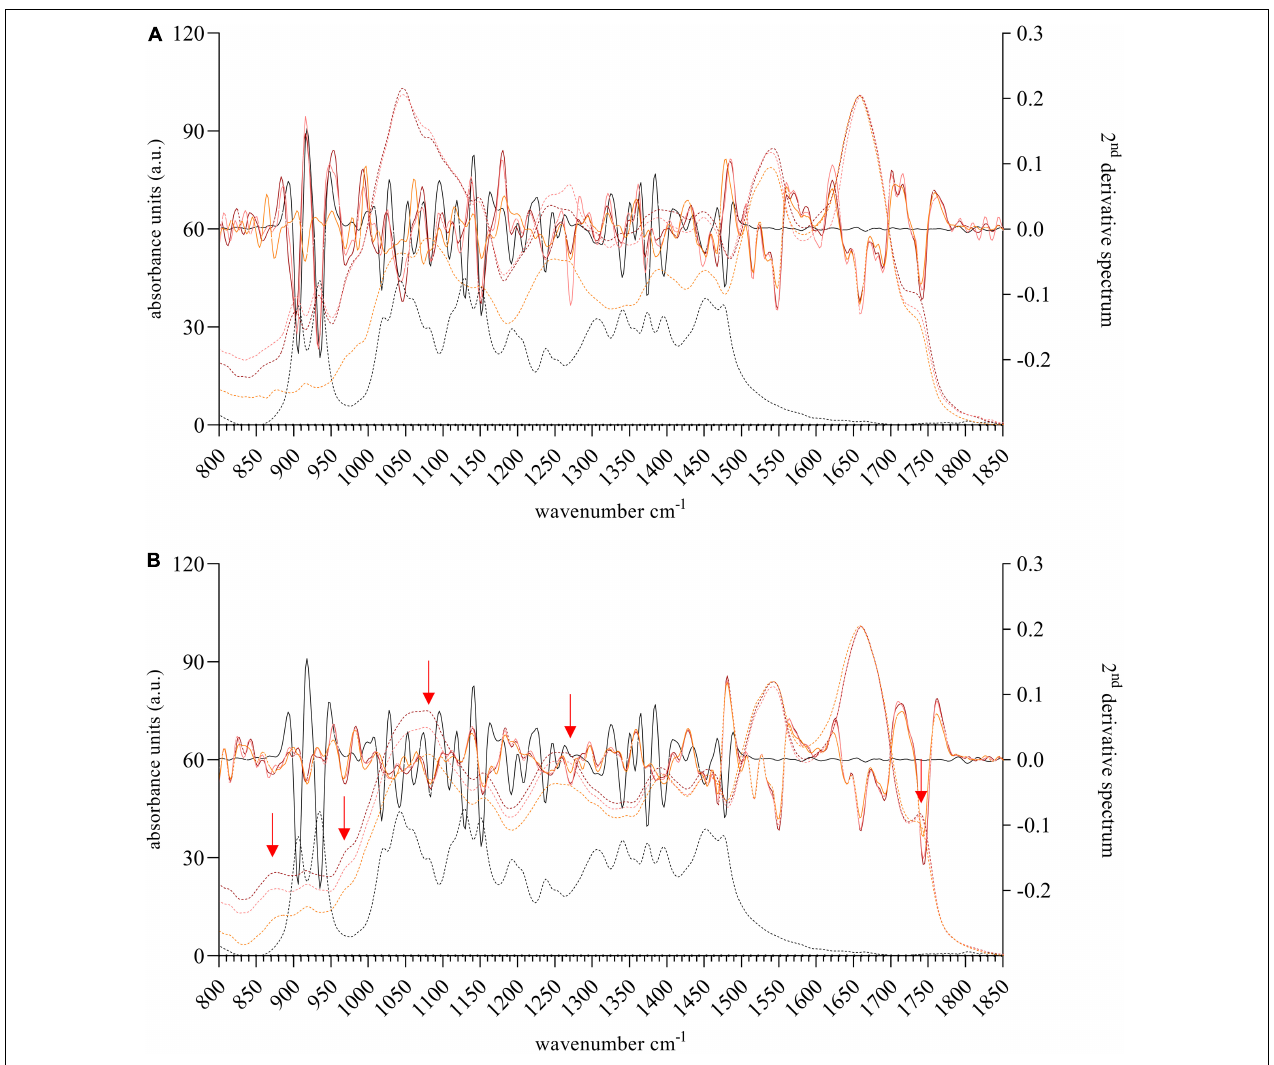
FIGURE 6 | FTIR spectra (dashed line) and 2nd derivative spectrum (solid line) of biomass derived from Coelastrella sp. (3–4) (A) and Scotiellopsis reticulata (UFA-2) (B) harvested after growth for 5 days in the presence of xylose [3 g L − 1 (light red) or 6 g L − 1 (dark red)]. The photoautotrophic control culture (orange) was grown in the absence of external carbon source, shown are also the negative control culture (N-free medium preventing algal growth, light blue) and the reference spectrum of xylose (black). The red arrows highlight the most prominent changes in the 2nd derivative spectra compared to the control. These cannot be assigned to